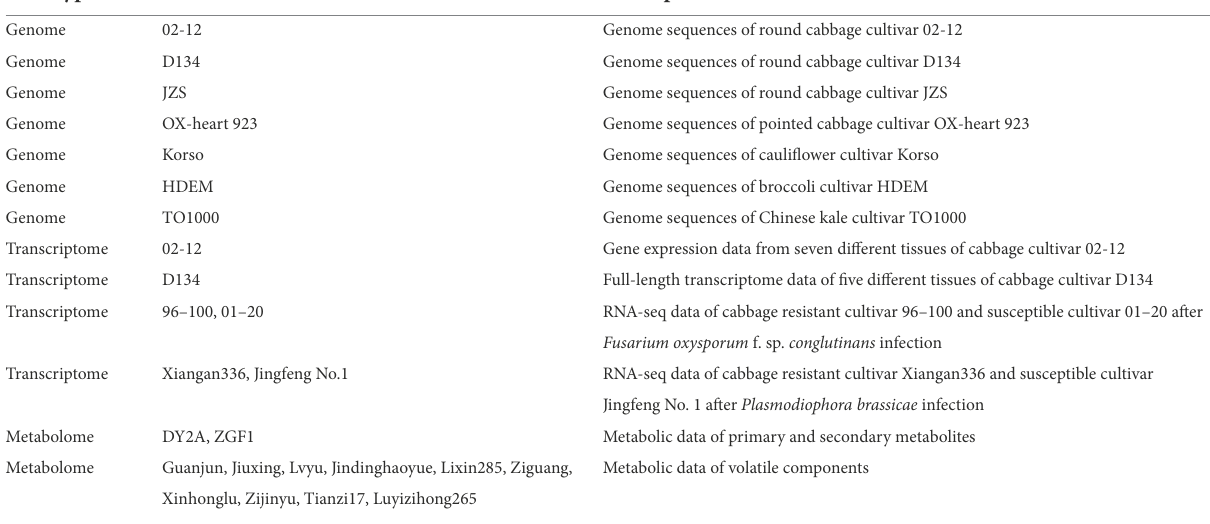
TABLE 1 Omics data information in the